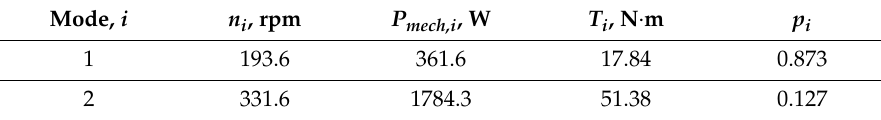
Table 3. The two-mode substituting profile.